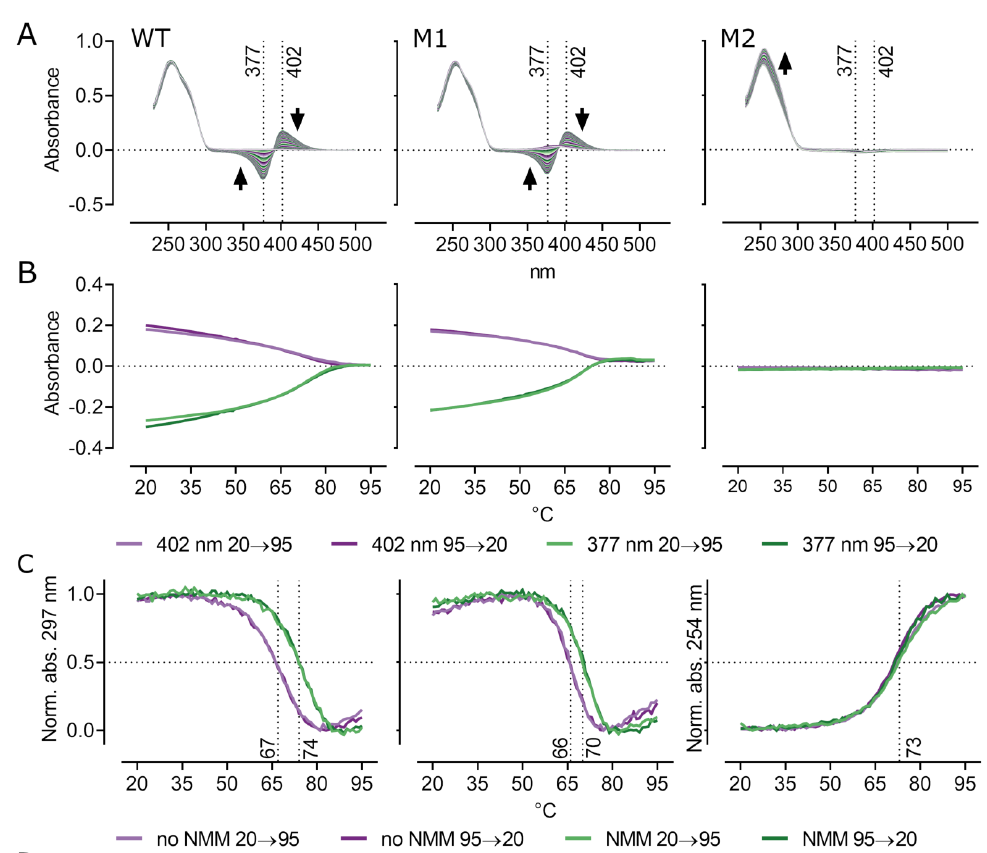
Figure 3. UV absorption spectroscopy and thermal melting. ( A ) Full absorption spectra obtained during heating from 20 to 95 ◦ C in 15 mM potassium and 7.5 µ M NMM show typical peaks at 377 and 402 nm of free and G4-bound NMM, respectively. Black arrows indicate peak development with increasing temperature. ( B ) Absorbance at 377 and 402 nm plotted against temperature revealing a disruption of NMM-G4 interaction due to the increase in temperature. ( C ) Comparison of normalized absorbance of WT and M1 at 297 nm shows the effect of NMM on G4 melting temperature and G4 stabilization by NMM in 15 mM potassium. Melting curves for M2 are calculated as normalized absorbance at 254